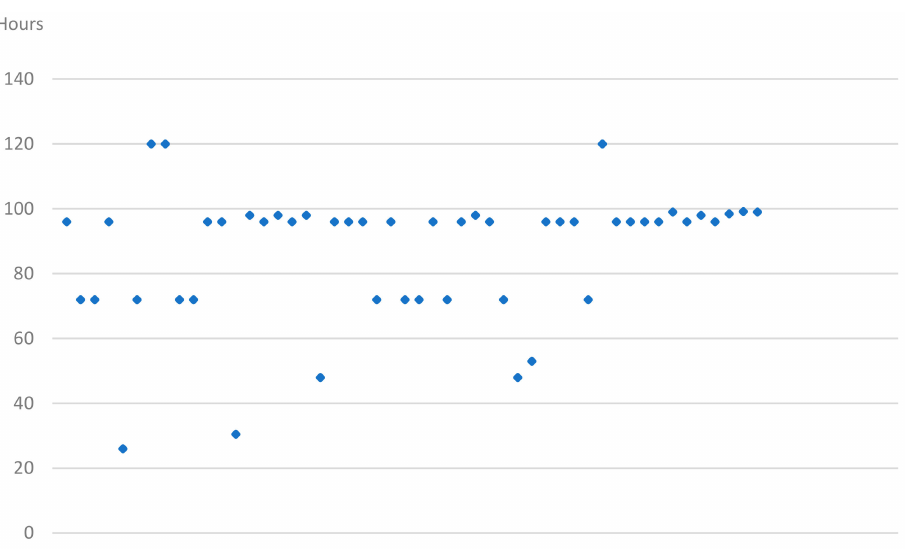
Figure 1. Duration of monitorization per patient in